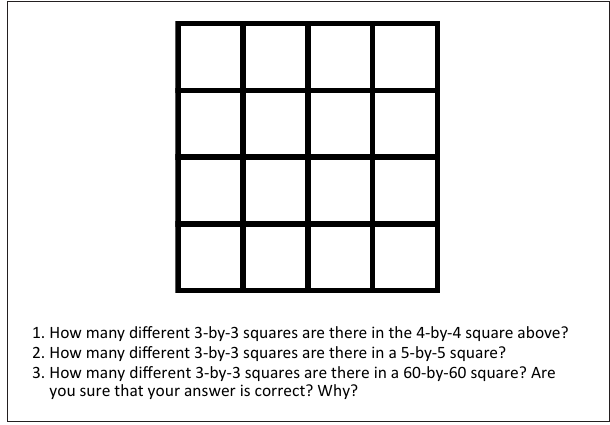
FIGURE 1: The Squares